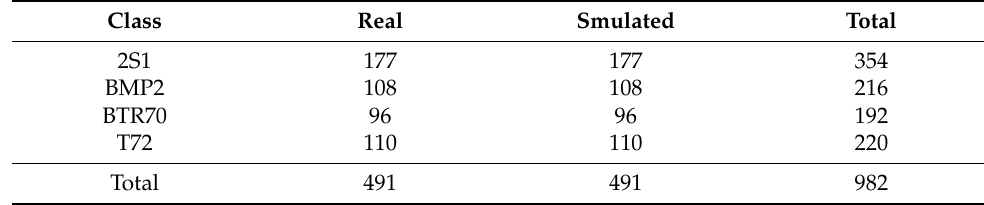
Table 2. Detail of SAMPLE data for each class.